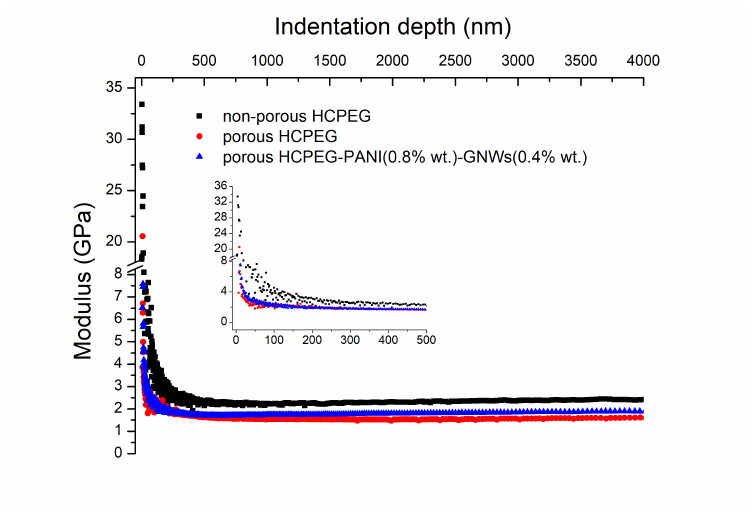
Figure 2. Nanoindentation experiments showing the Young’s Modulus (GPa) as a function of the indentation depth HCPEG, porous HCPEG, and porous HCPEG filled with PANI (0.8% wt) (c) and PANI (0.8% in wt) plus GNWs (0.4%